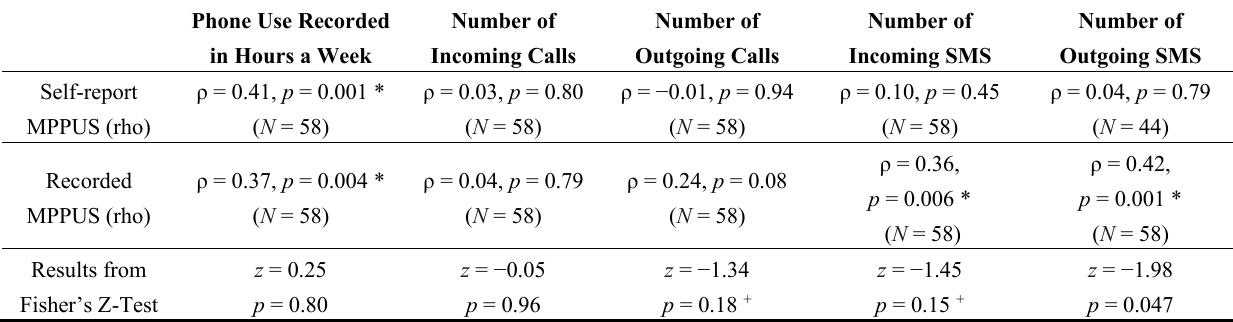
Table 2. Correlations between Mobile Phone Problem Use Scale (MPPUS) and recorded telephone variables; correlations are presented with p -values for two-sided